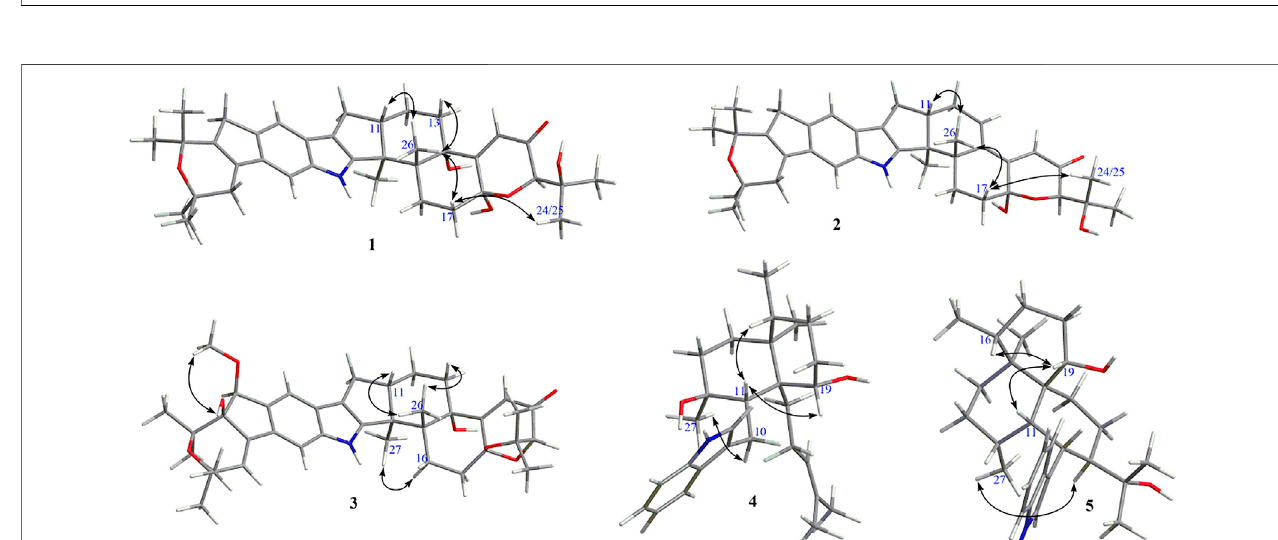
FIGURE 3 | Selected ROESY correlations of 1 – 5